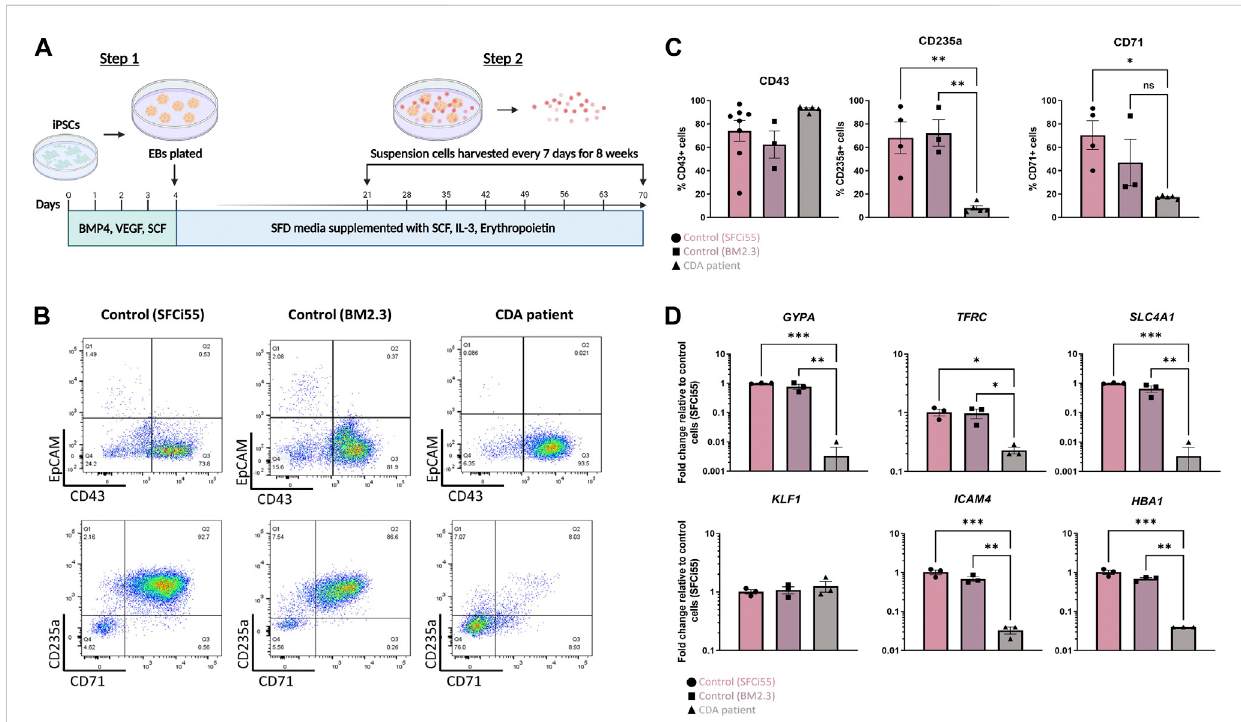
FIGURE 1 ErythroidprogenitorsgeneratedfromaCDApatient-iPSClinerecapitulatediseasepathology. (A) SchematicofcultureprotocoltodifferentiateiPSC into erythroid cells. Flow cytometry analyses, and RNA extraction for gene expression analyses were perfomed on the day that suspension cells were harvested (B) Representative fl ow cytometry plots of cell surface expression of CD43, EpCAM, CD235 and CD71 of suspension cells isolated from two controliPSClines(SFCi55andBM2.3)andoneiPSClinederivedfromaCDAtypeIVpatient.Datapointsrepresentindividualsuspensioncellharvests. (C) Quanti fi cation of fl ow cytometry analyses of cell surface marker expression. (D) Gene expression analyses of GYPA (CD235a), TRFC (CD71), SLC4A1 ( B and3), HBA1 (hemoglobinsubunitalpha), ICAM4 and KLF1 insuspensioncellsderivedfromtwocontrolandonCDApatient-derivediPSCline.Errorbars represent SEM. One-way ANOVA with Tukey post-test. * p < 0.05, ** p < 0.01. Datapoints represent individual suspension cell harvests. The schematic diagram in (A) was created using